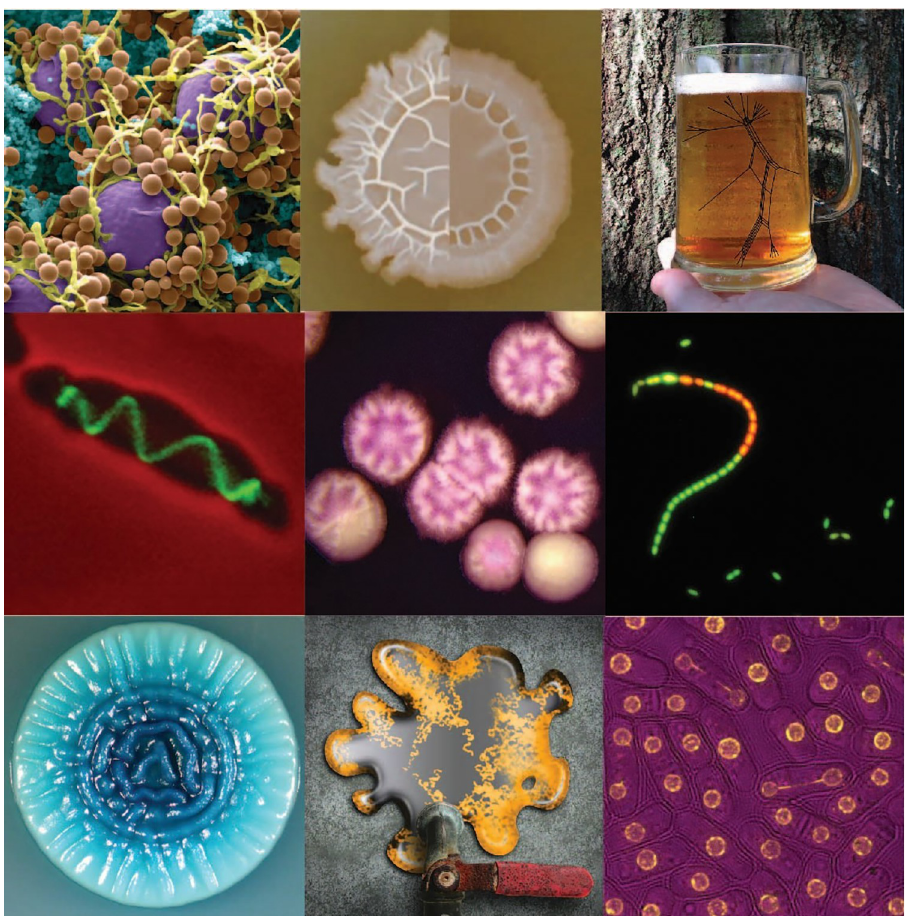
Fig 1. A collage of cover images from previous issues of PLOS Genetics showcasing the remarkable and beautiful diversity of the microbial world. Top row: Aspergillus nidulans (Image credit: O¨zgu¨r Bayram and Gerhard H. Braus); Bacillus subtilis (Image credit: Kazuo Kobayashi); beer brewed from yeast related to Saccharomyces eubayanus (Image credit: A. B. Hulfachor). Middle row: Streptococcus pneumoniae (Image credit: Aurore Fleurie); Candida tropicalis (Image credit: Han Du, Qiushi Zheng); Lactococcus lactis (Image credit: Pascal Le Bourgeois). Bottom row: Candida albicans (Image credit: Oliver Homann and Jeanselle Dea); Rhodococcus opacus (Image credit: Jason Holder, Leslie Gaffney, Lauren Solomon); Schizosaccharomyces pombe (Image credit: Helena